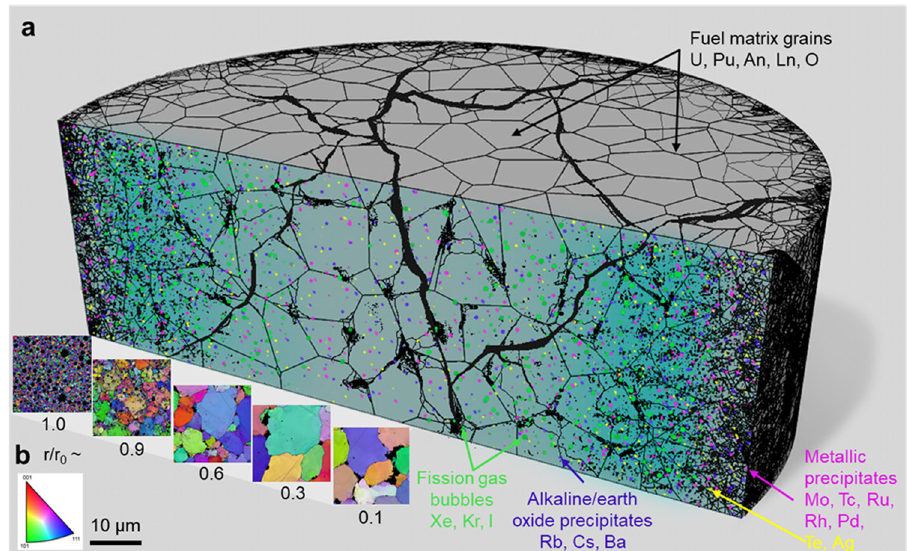
Fig. 1 Schematic cross-sectional view of the spent nuclear fuel microstructure. a Magenta and yellow elements are metallic precipitates formed by fi ssion products, whereas green elements are bubbles or pores formed through fi ssion gas release such as Xe, Kr, I. The fi ssion products can segregate in the crack and decorate both the surfaces of the grain boundaries and grain interiors, resulting in further intragranular/intergranular bubble swelling. The grain restructuring (subdivision) occurs at the transition region and fully develops into submicron grains toward the fuel rim. b Selected EBSD scans in a fuel from the Limerick NPP are provided as an example to demonstrate the grain structure at fi ve different radial positions. The transition region has a combination of both large and submicron grains, and the rim indicates the fully developed